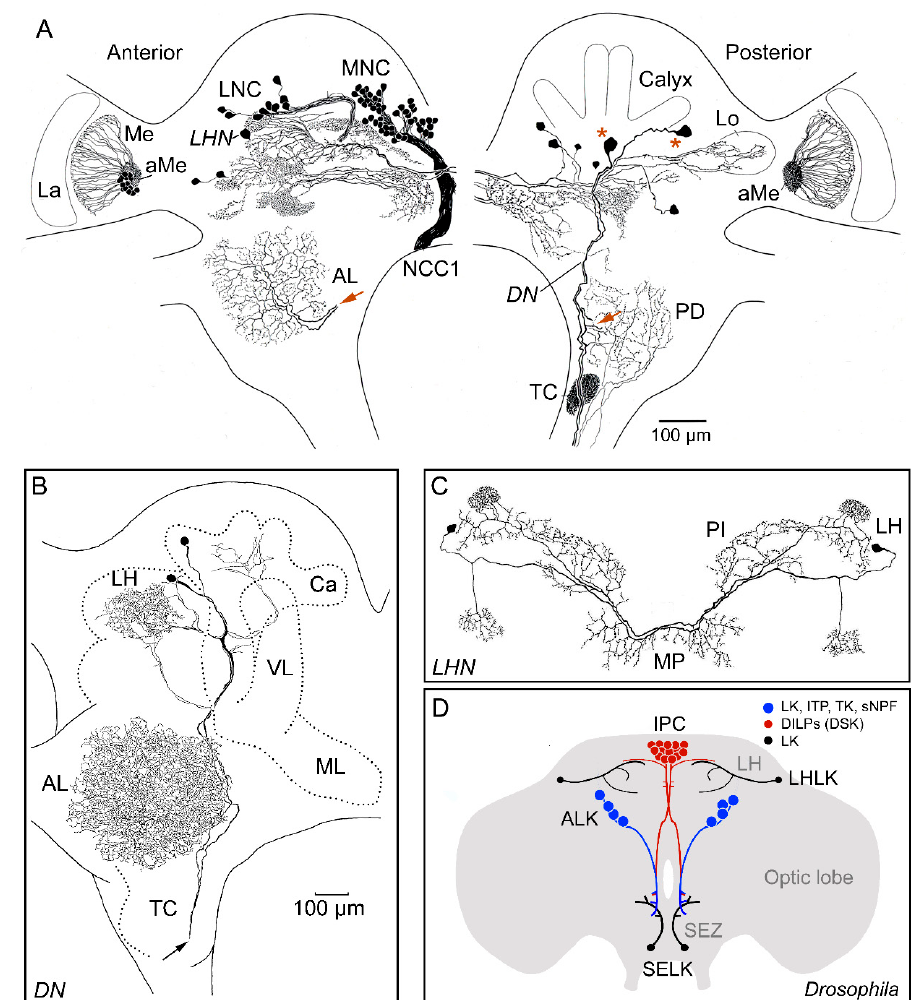
Figure 5. Leucokinin (LK)-expressing neurons in the brain of the cockroach Leucophaea maderae ( Rhyparobia maderae ). ( A ) Anterior part of the brain is shown to the left and posterior to the right. Note that the brain contains about 160 LK neurons, all with cell bodies in the protocerebrum. There are LK expressing lateral (LNC) and median neurosecretory cell groups (MNC). The MNCs send axons to the corpora cardiaca via the nerve NCC1 on the contralateral side; the LNCs send axons ipsilaterally via the nerve NCC2 (not shown). A pair or descending neurons ( DN ) in each hemisphere (cell bodies at red asterisks) send axons to the thoracic and abdominal ganglia and have collateral branches arborizing in the antennal lobe (red arrows show where collaterals are). A set of LK neurons have processes in the accessory medulla (aMe) and medulla (Me). A neuron in each hemisphere ( LHN ) has arborizations similar to the LHLKs (lateral horn LK neurons) in Drosophila . Other abbreviations: La, lamina; TC, tritocerebral neuropil; PD, posterior deutocerebrum, Lo, lobula. This figure is from [27]. ( B ) Detailed tracing of descending neurons ( DN ) with branches in the antennal lobe (AL), lateral horn (LH), and calyx (Ca) of mushroom body and axons (arrow) running through the tritocerebrum (TC) and circumesophageal connectives to the ventral nerve cord. VL, vertical lobe, ML, median lobe. ( C ) A pair of LK neurons ( LHN ) with branches in lateral horn (LH), pars intercerebralis (PI), and median protocerebrum, resembling LHLKs in Drosophila (see panel D). ( D ) Schematic depiction of LK neurons in the adult Drosophila brain. LHLKs are located in the lateral horn (LH) and branch extensively in dorsolateral protocerebrum and contact the insulin-producing cells (IPC), known to also produce drosulfakinin (DSK). SELKs (subesophageal LK neurons) are descending neurons with extensive branches in the subesophageal zone (SEZ) and tritocerebrum. ALKs (anterior LK neurons) are lateral neurosecretory cells that only express LK in small and variable amounts in the adult and are known to coexpress ion transport peptide (ITP), tachykinins (TK), and short neuropeptide F (sNPF). Panels ( A ) and ( C ) are from [27] and ( B ) is from [81] (tracing by U. Homberg), all with permission. ( D ) is compiled de novo from data in [33,51,82].